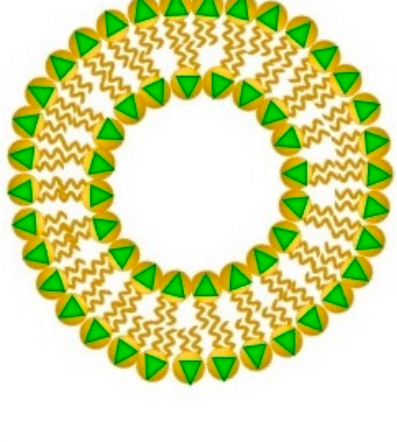
Figure 7. Schematic structure of phytosomes lipid vesicular system.